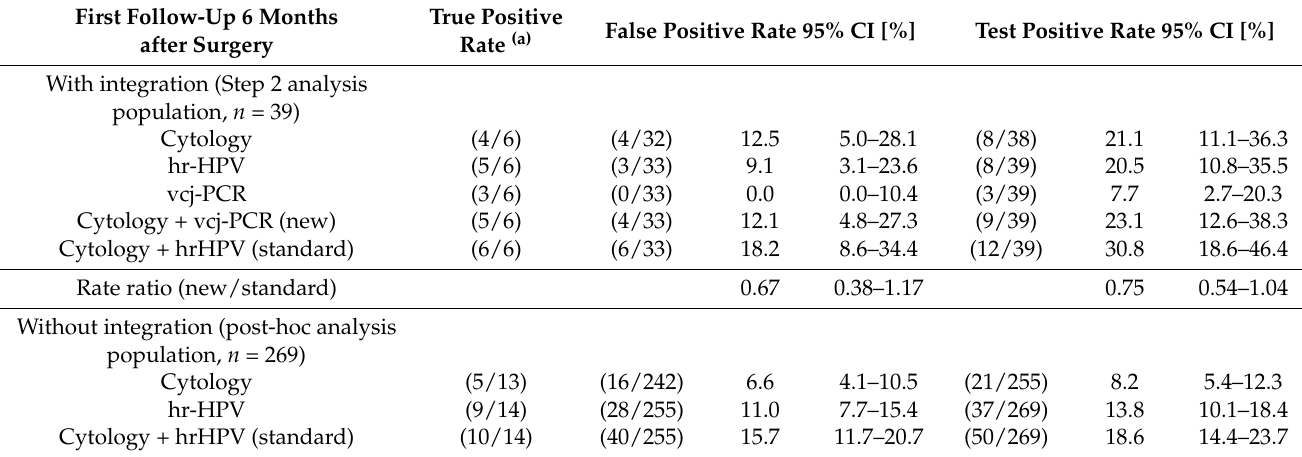
Table 2. True, false and test positive rates of first follow-up tests in patients with and without HPV16/18 DNA integration to predict recurrent pre-cancer at visit or afterwards.